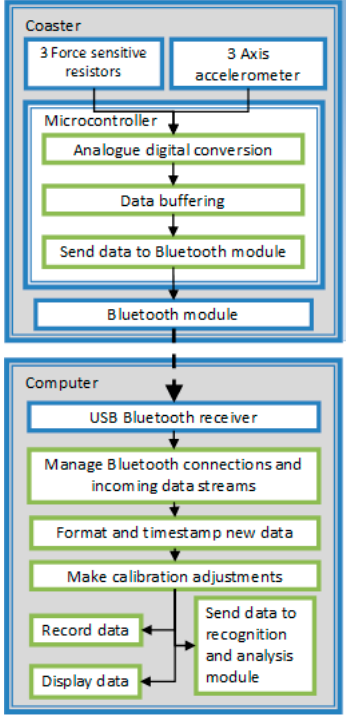
Figure 4. Coaster system design.